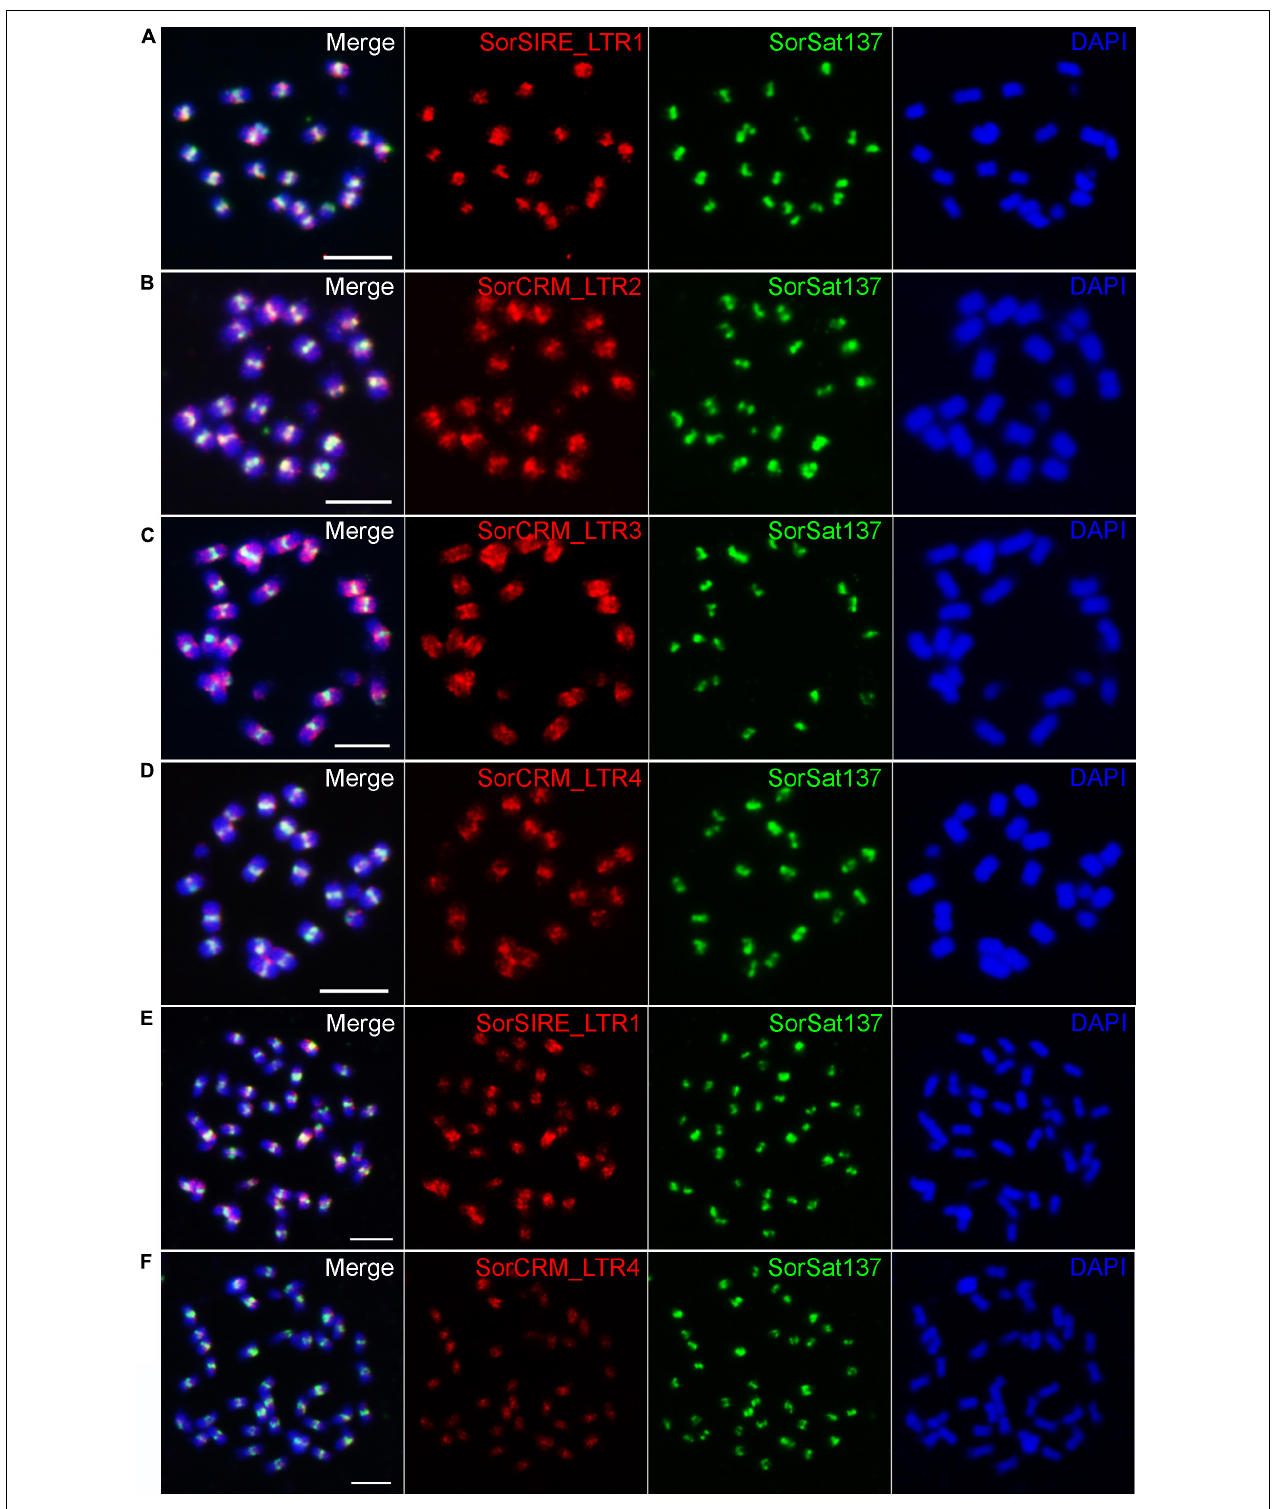
FIGURE 6 | Fluorescence in situ hybridization mapping of centromeric repeats in S. bicolor and S. halepense . In S. bicolor , colocalization of (A) SorSIRE_LTR1, (B) SorCRM_LTR2, (C) SorCRM_LTR3, and (D) SorCRM_LTR4 with the centromeric satellite SorSat137, confirming the centromere enrichment of LTR repeats. The conserved centromeric distribution of (E) SorSIRE_LTR1 and (F) SorCRM_LTR4 in S. halepense is shown. Chromosomes were counterstained with DAPI. Bar = 5 µ m.